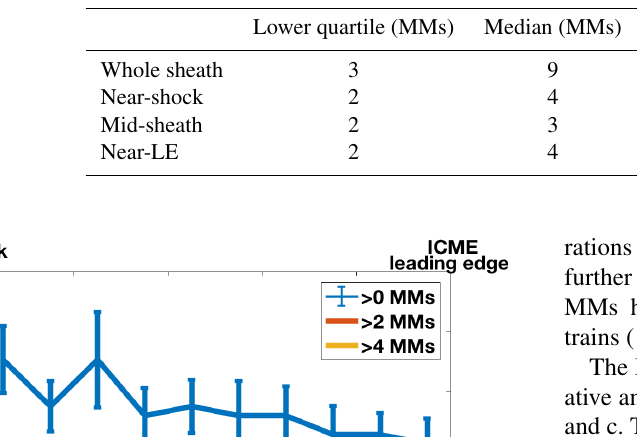
Table 2. Quartiles of ICME-driven sheath regions (whole sheath) and different sub-regions according to the number of MMs in them. The quartiles are computed for those ICME-driven sheaths and sub-regions that contained MMs. The last column shows the percentage of sheaths with more than 24 MMs in the sub-region in question.